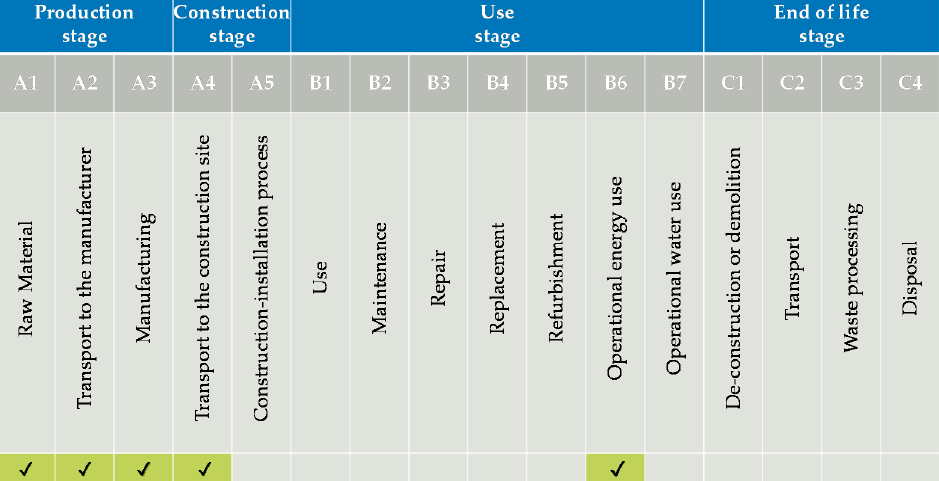
Figure 5. Life cycle stages considered in this study (green marked).